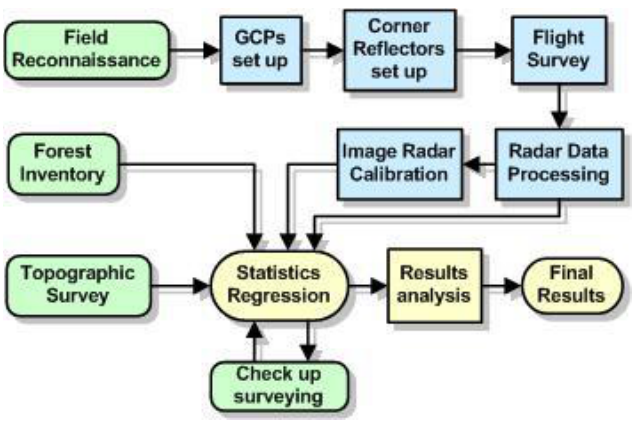
Figure 2. Methodological procedure